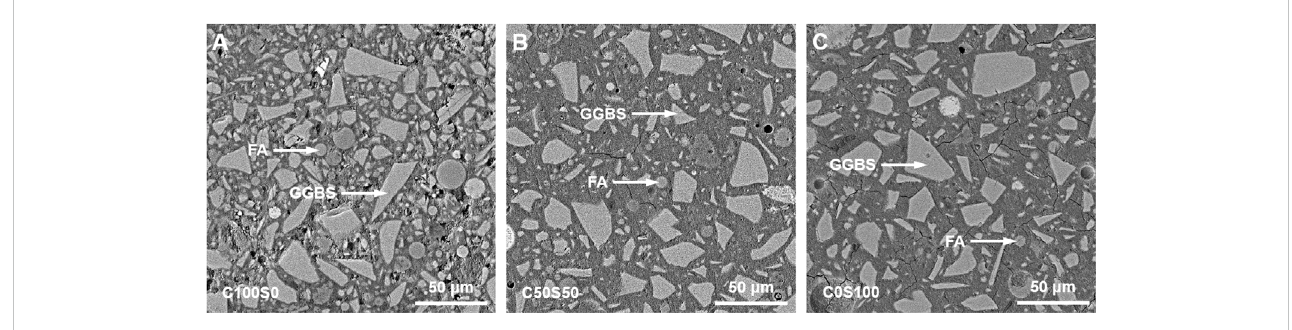
FIGURE 5 BSE images of SH-UHPGC pastes with different activators: (A) C100S0, (B) C50S50, and (C) C0S100.